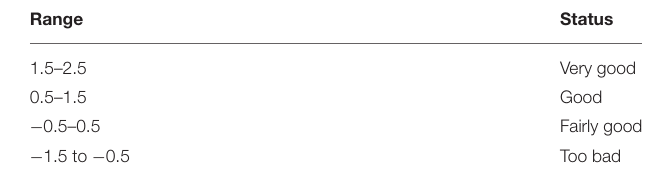
TABLE 4 | Range on a rating point ( − 1– + 2) used for social distancing